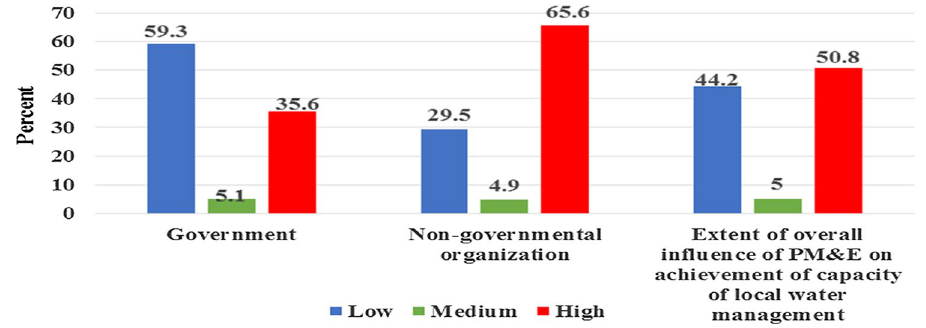
Fig. 3 Effectiveness of PM&E